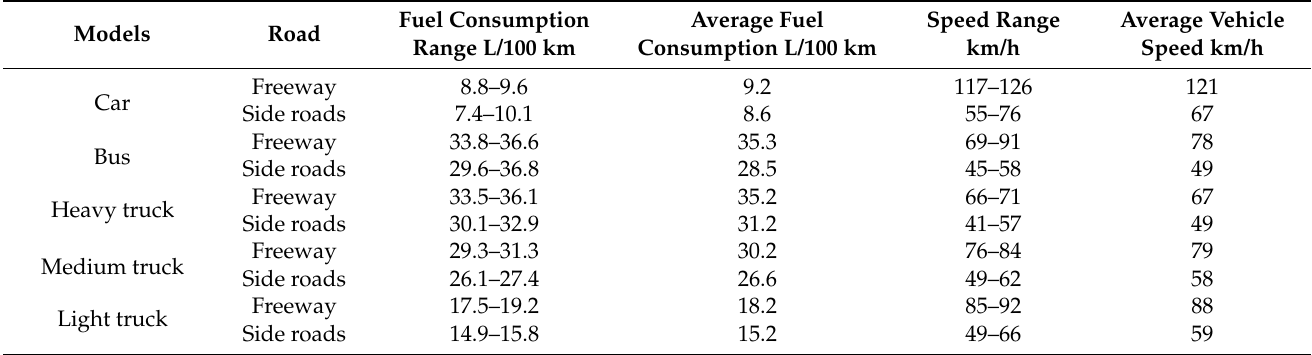
Figure 1. Relationship between vehicle speed and fuel consumption (Medium light vehicle). Referring to the references [47], the relationship between fuel consumption and vehicle speed of different models listed in Table 2 is obtained. Table 2. The relationship between fuel consumption and vehicle speed of different models.